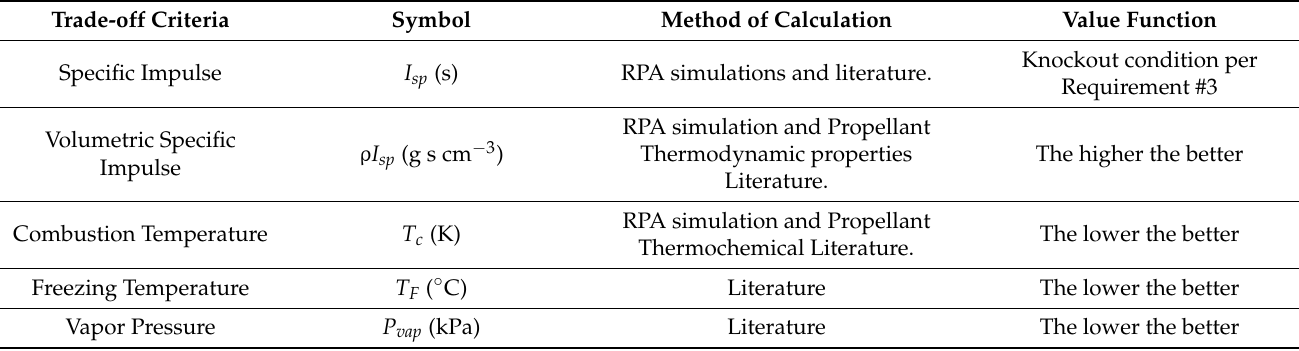
Table 7. Propellant trade-off criteria.